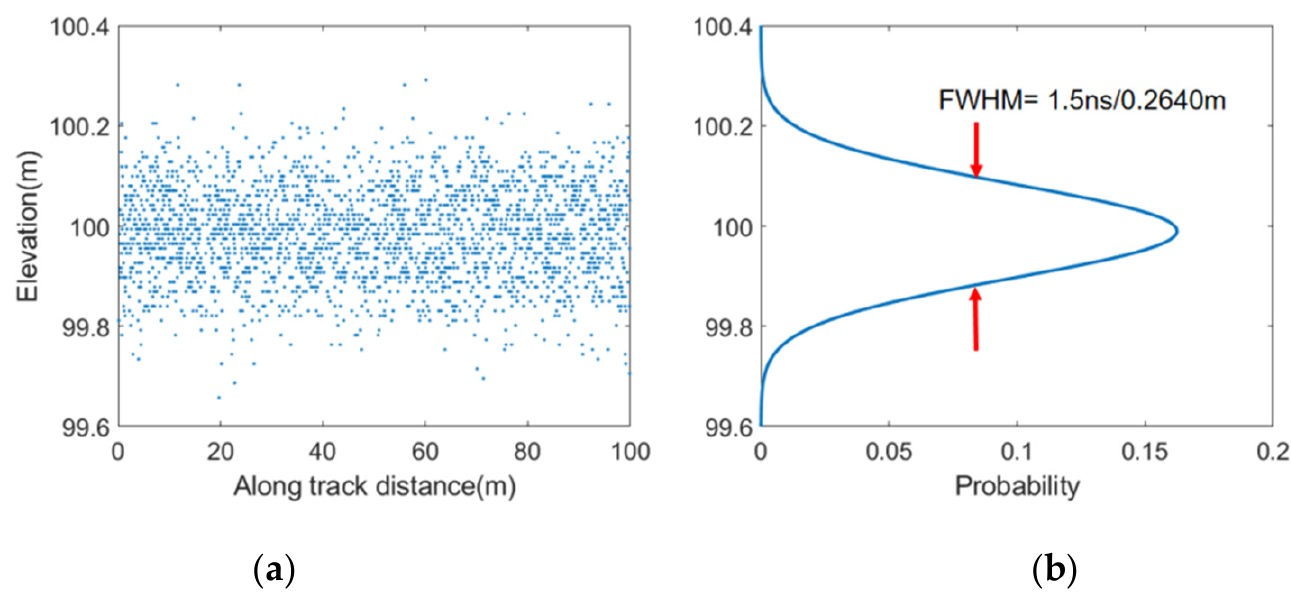
Figure 3. Signal simulation results without noise ( p = 0.25). ( a ) Two-dimensional scatter plot of signal simulation results. ( b ) When p = 0.25, the detection probability distribution of photons arriving at different altitudes, and its FWHM = 1.5ns/0.2640m.